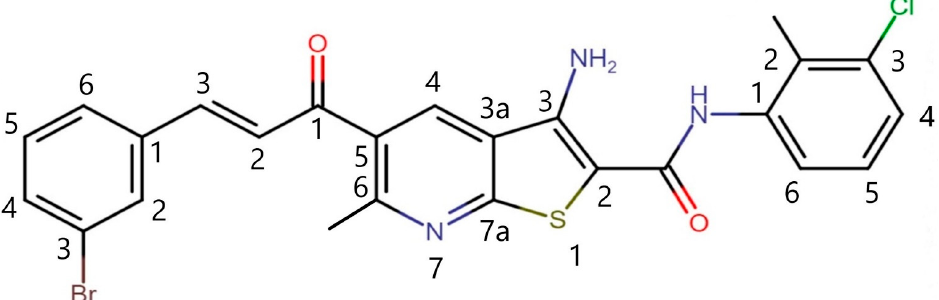
Figure 11. The structure of the newly synthesized anticancer agent (compound 1 ). Note: Compound 1 , ( E )-3-amino-5-(3-(3-bromophenyl)acryloyl)- N -(3-chloro-2-methylphenyl)-6-methylthieno [2,3- b ]pyridine-2-carboxamide.